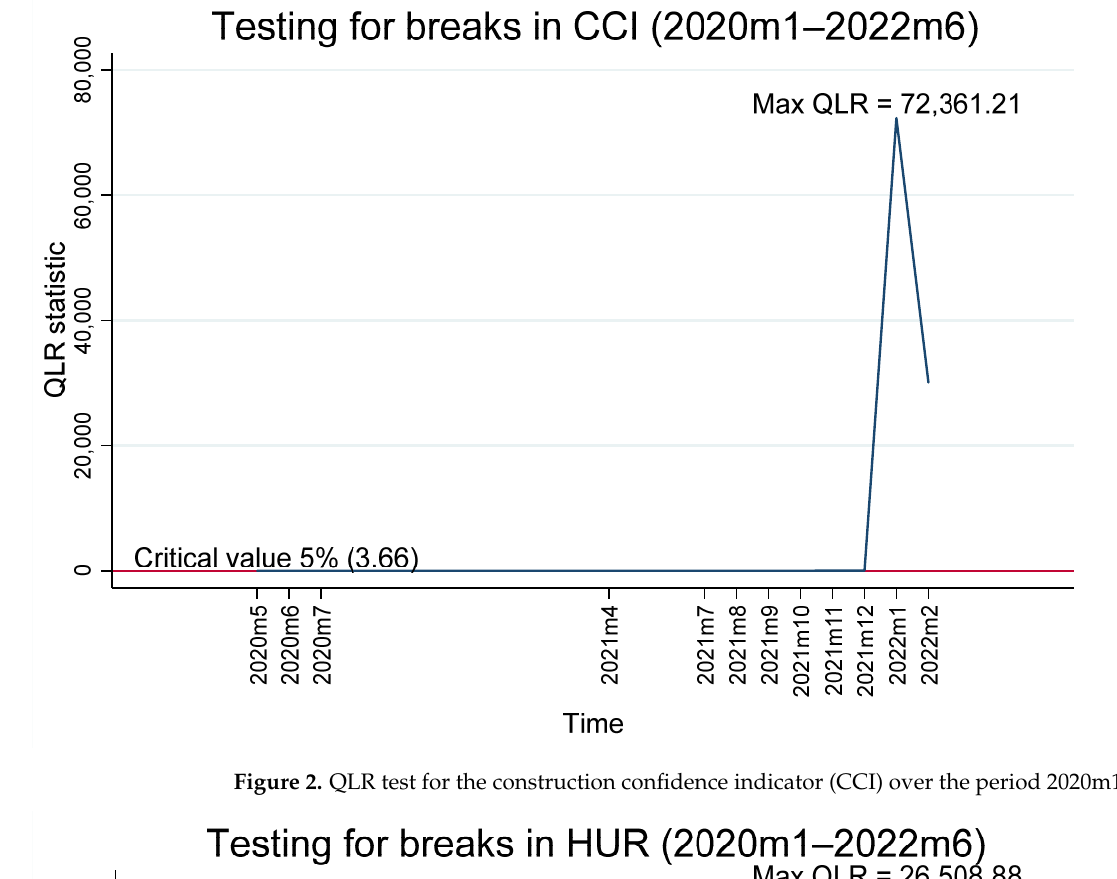
Figure 2. QLR test for the construction confidence indicator (CCI) over the period 2020m1–2022m6.